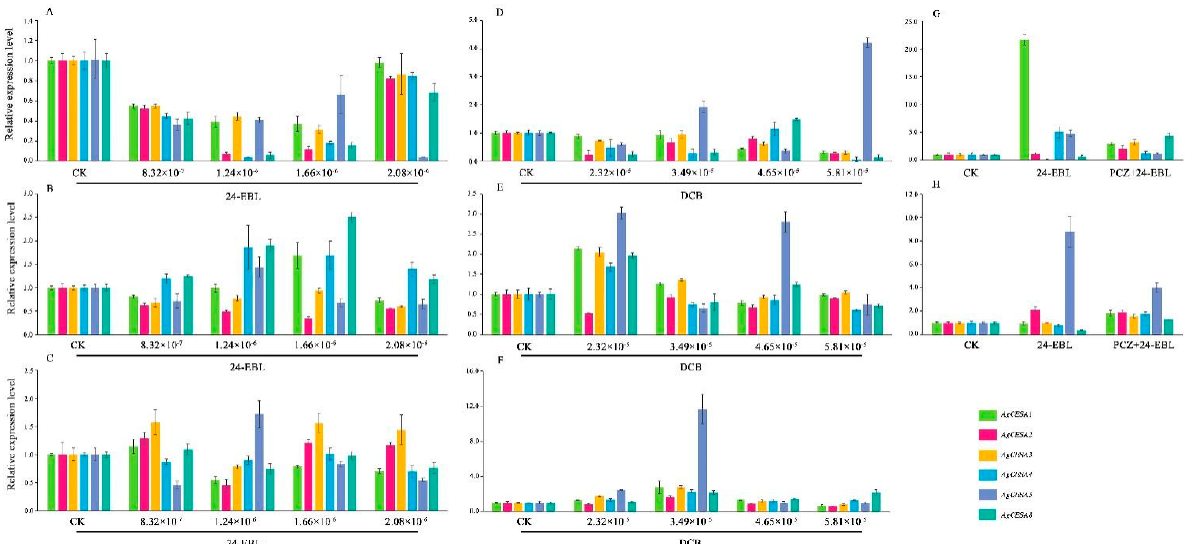
Figure 9. The expression levels of the genes related to cellulose biosynthesis in petioles, leaf blades and hypocotyl of celery under different concentrations of 24-EBL/PCZ/DCB treatments. ( A ) Celery leaf blades under 24-EBL treatments. ( B ) Celery petioles under 24-EBL treatments. ( C ) Celery hypocotyl under 24-EBL treatments. ( D ) Celery leaf blades under DCB treatments. ( E ) Celery petioles under DCB treatments. ( F ) Celery hypocotyl under DCB treatments. ( G ) Celery leaf blades under PCZ + 1.24 × 10 − 6 mol/L 24-EBL treatments. ( H ) Celery petioles under PCZ + 1.24 × 10 − 6 mol/L 24-EBL treatments. Column diagrams with different colors represent the expression levels of AgCESA1 , AgCESA2 , AgCESA3 , AgCESA4 , AgCESA5 and AgCESA8 , respectively. Data are expressed as the means ± standard deviation (SD) of three replicates.